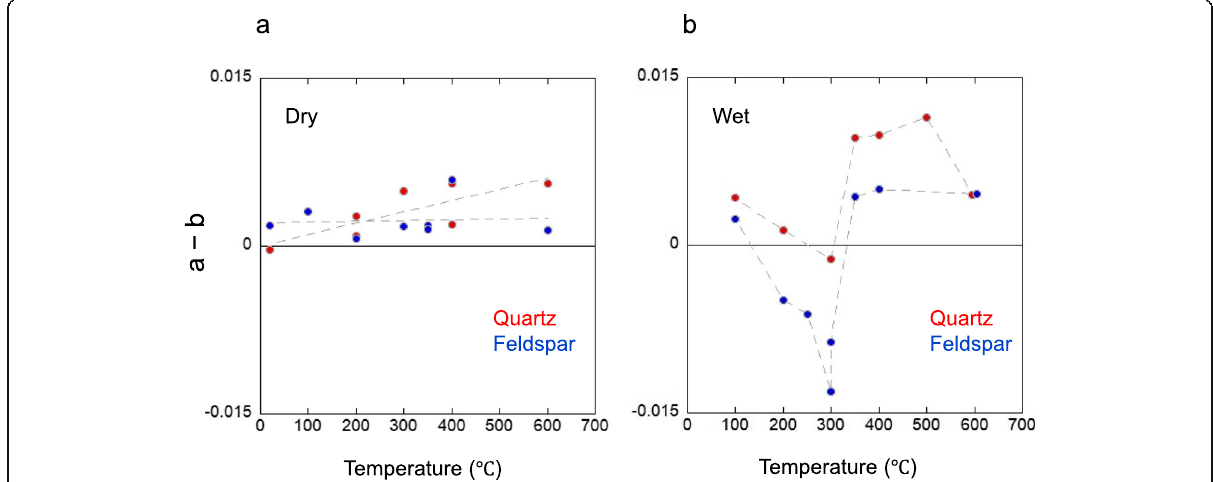
Fig. 4 Velocity dependence of steady-state friction ( a – b ) as determined from Eq. (2) for quartz and feldspar plotted as a function of temperature. a Dry condition, P c =150MPa (Ar gas); b wet condition, P c =200MPa (Ar gas), P p (pore pressure)=50MPa (distilled